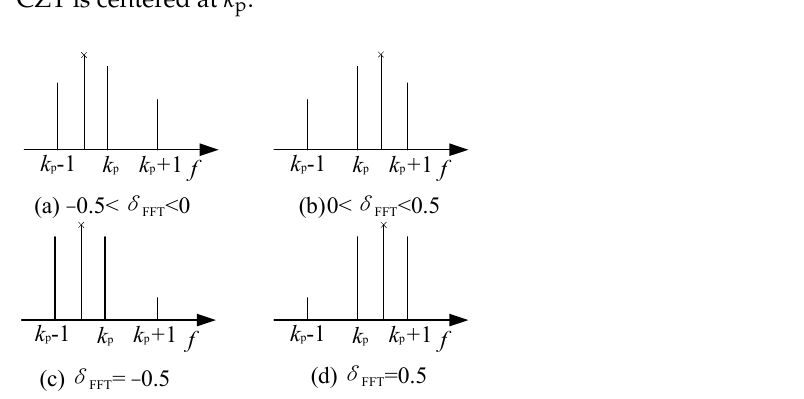
Figure 2. FFT spectrum lines with various δ FFT (real frequency is marked by an oblique cross).